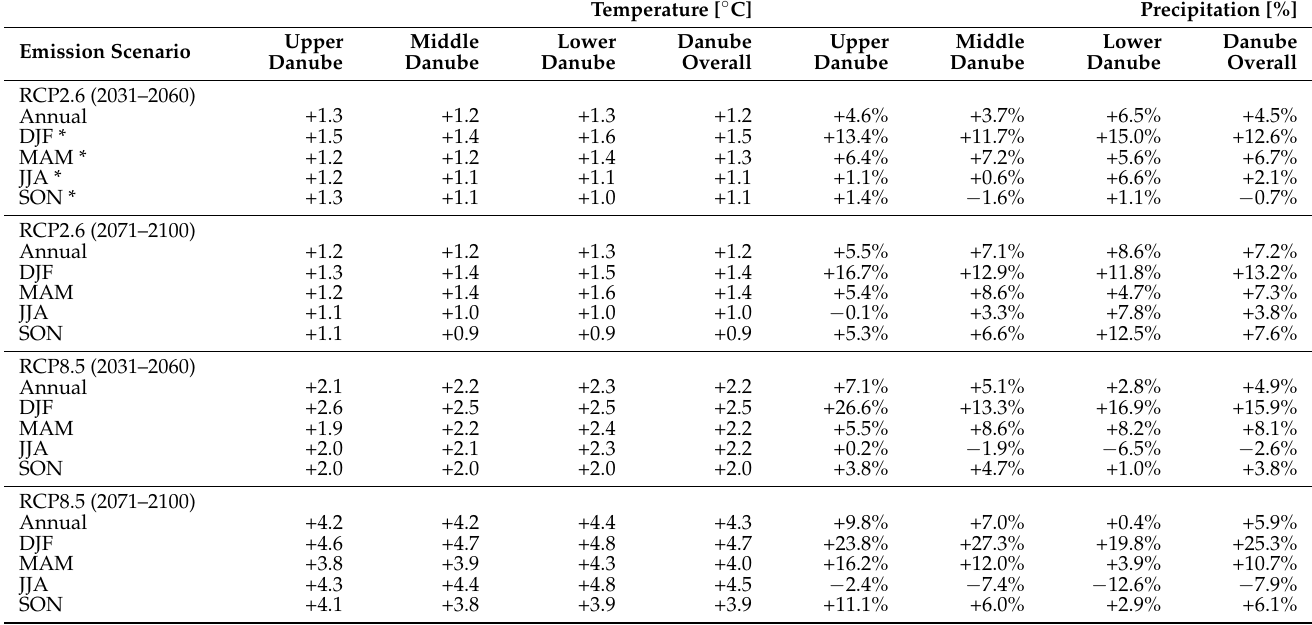
Table 2. Changes in the long-term mean annual and seasonal temperature [ ◦ C] and precipitation [%] on spatial average for the Upper, Middle and Lower Danube as well as for the Danube overall according to the GCM-RCM-driven simulations (ensemble mean) under RCP2.6 and RCP8.5 for the near future (2031–2060) and the far future (2071–2100) compared to the historical GCM-RCM-driven simulations (ensemble mean,